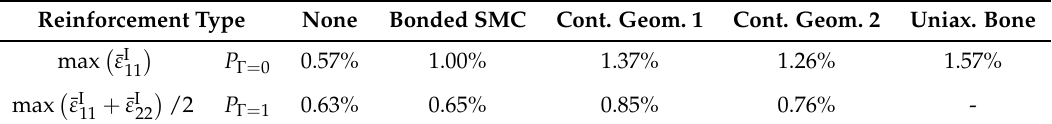
Table 2. Maximum attained strain within one experiment for the different biaxial specimen designs and, for reference, the failure strain of a uniaxial bone specimen. Here, the operator max ( · ) denotes the maximum value in the course of the experiment. Reinforcement